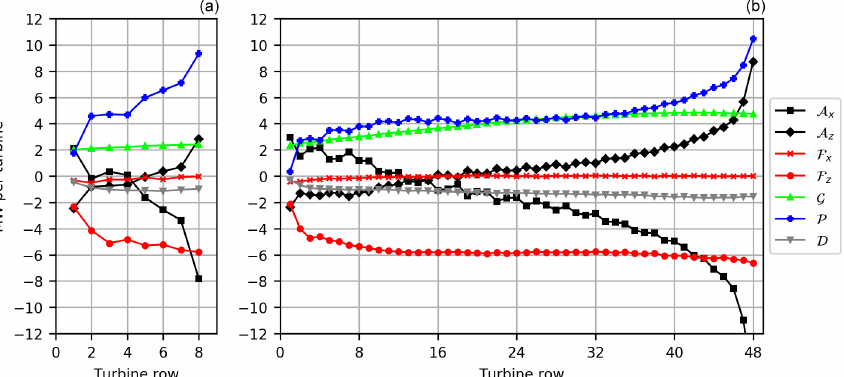
Figure 14. Energy budgets inside the BL control volumes (cid:127) bl for the small wind farm (a) and the large wind farm (b) . The budget terms are horizontal advection of KE ( A x ), vertical advection of KE ( A z ), turbulent fluxes through left/right ( F x ) and bottom/top ( F z ) surfaces, geostrophic forcing ( G ), perturbation pressure gradients ( P ), and dissipation ( D ). The buoyancy term ( B ) is not shown because it is very small. There is no energy extraction by wind turbines ( W ) in the BL control